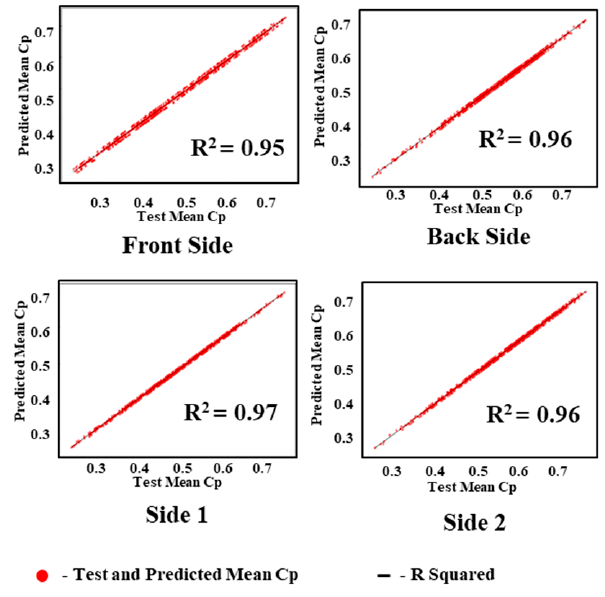
Figure 22. Predicted mean pressure coefficient by GAIN.